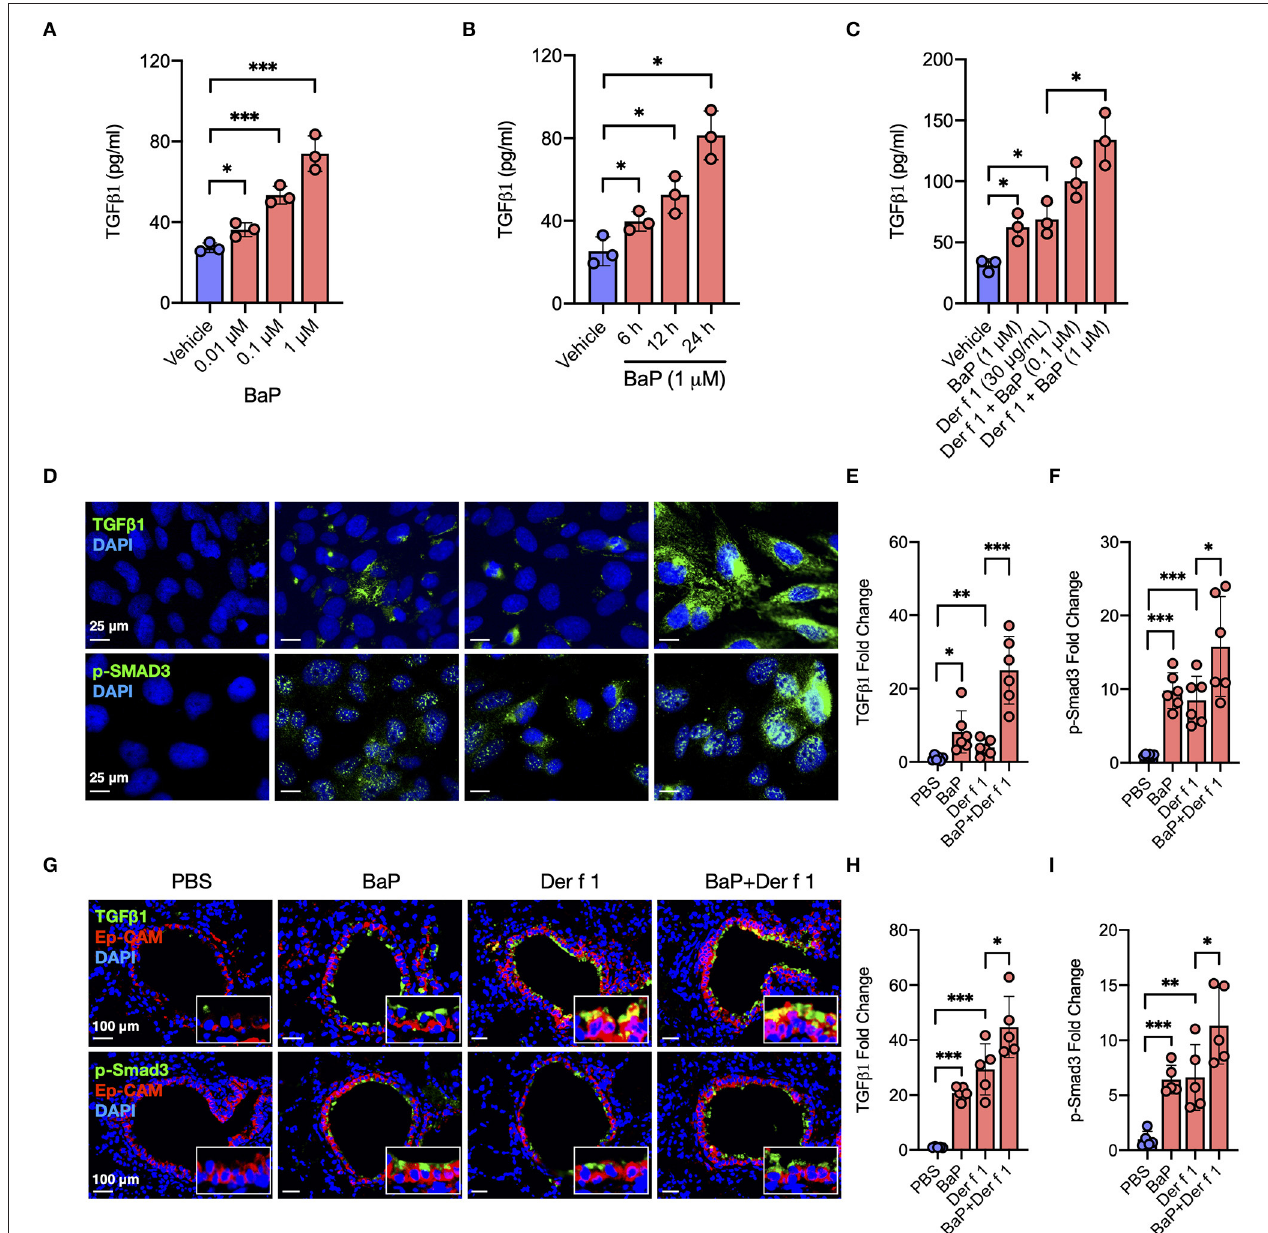
FIGURE 1 | BaP co-exposure exacerbates Der f 1-induced TGF β 1 secretion and signaling activation. (A,B) Levels of TGF β 1 in supernatants of 16HBECs treated with BaP at varying doses (0.01–1 µ M) (A) and different times (6–24h) (B) . (C) Levels of TGF β 1 in supernatants of 16HBECs treated with BaP (1 µ M) and Der f 1 (30 µ g/ml) alone or in combination. (D) Expression of TGF β 1 and p-SMAD3 in the surface of 16HBECs treated with BaP (1 µ M) and Der f 1 (30 µ g/ml) alone or in combination. (E,F) Quantitative analysis of TGF β 1 (E) and p-Smad3 (F) fluorescent signal ( n = 6). (G) Representative immunofluorescence images of TGF β 1 (green) and p-SMAD3 (green) expression in the airway epithelial cells (EpCAM, red) of an asthma mouse model. (E,F) Quantitative analysis of AhR and RhoA fluorescent signal in (G) ( n = 6 mice/group). (H,I) Fluorescent-positive cells of tissue sections were quantified in at least four different high-power fields (500 µ m 2 ) in two to three different lung sections per mouse by using Fiji ImageJ. Data represent mean ± SEM. * p < 0.05, ** p < 0.01, and *** p <